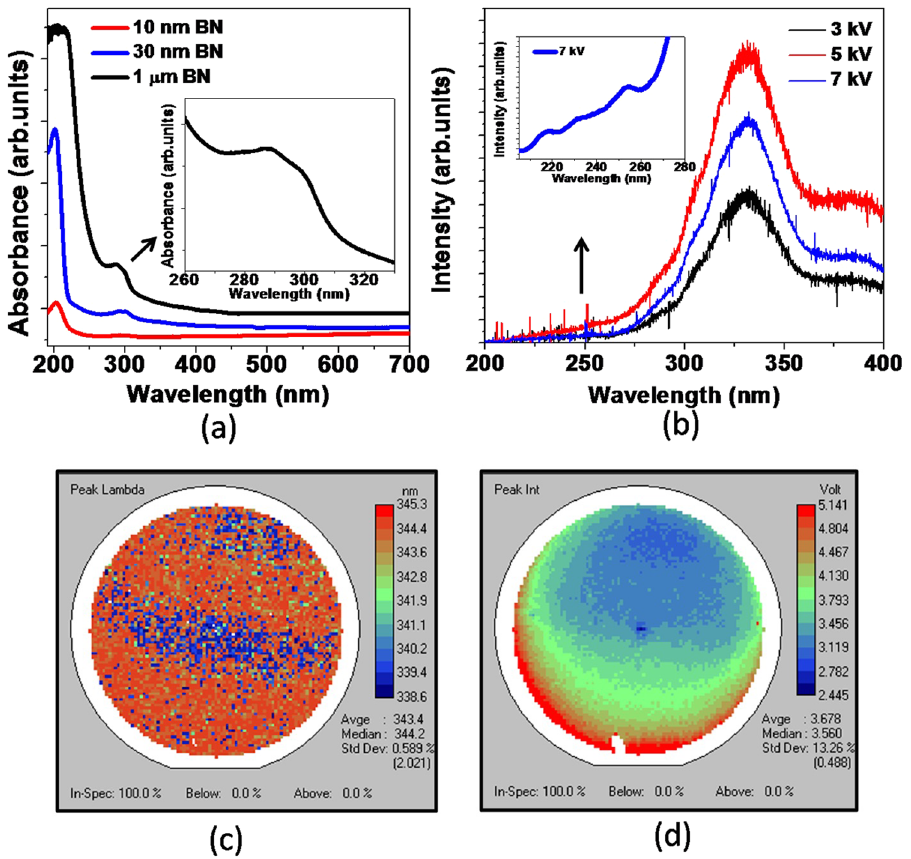
Figure 4. ( a ) Absorption spectrum of 1 µ m BN grown on sapphire substrate compared with the absorption spectra of 10 nm and 30 nm 2D layered h-BN. Inset shows the absorption peaks related to defect levels. ( b ) Cathodoluminescence at 77 K under different excitation energy and inset shows the CL peaks in deep UV region. ( c ) Wavelength distribution and ( d ) intensity distribution of photoluminescence mapping performed at room temperature for 2-inch 1 µ m BN/sapphire